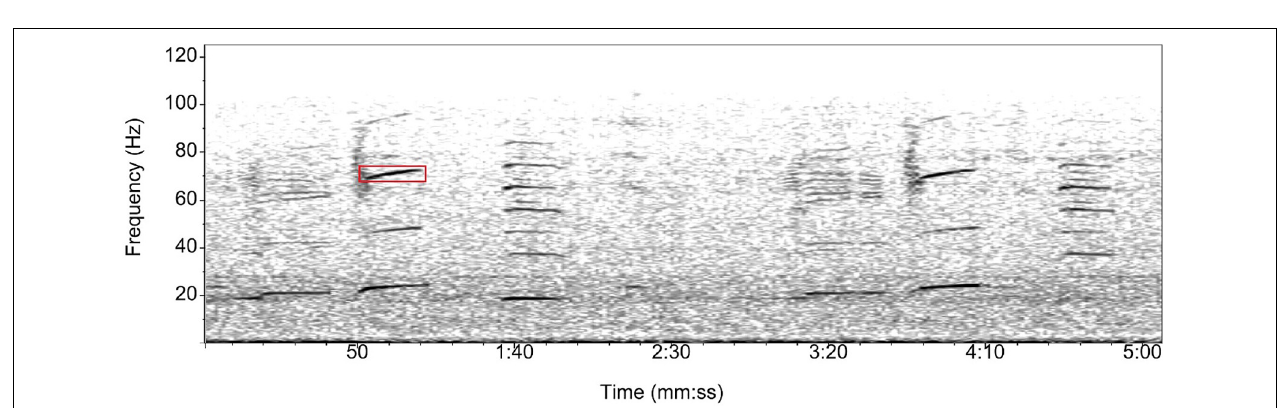
FIGURE 2 | Spectrogram of the Chilean or Southeast Pacific (SEP) blue whale calls: (A) SEP1 call and (B) SEP2 call. The red box shows the part of the call targeted by the automated energy-ratio detector in Ishmael. Spectrogram parameters: Hamming window, 1,024 points FFT, 50% overlap.